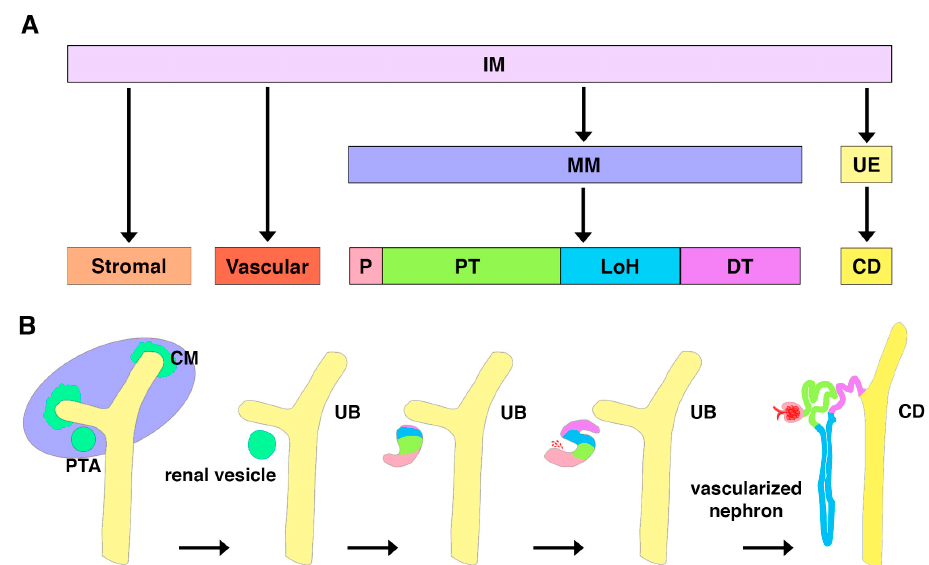
Figure 3. Mammalian mesodermal and nephron development. Simplified lineages and anatomical stages of the developing mammalian kidney are depicted. ( A ) The intermediate mesoderm (IM) will form the stromal, vascular, metanephric mesenchyme (MM), and ureteric epithelium (UE). MM develops into the podocyte (P), proximal tubule (PT), Loop of Henle (LoH), and distal tubule (DT), while the UE results in the collecting duct (CD). ( B ) Anatomical stages are shown first with condensation resulting in cap mesenchyme (CM) and pretubular aggregates (PTA) around the ureteric bud (UB). CM and PTA are followed by formation of the renal vesicle, comma-shaped body, S-shaped body, and vascularized nephron. Adapted from